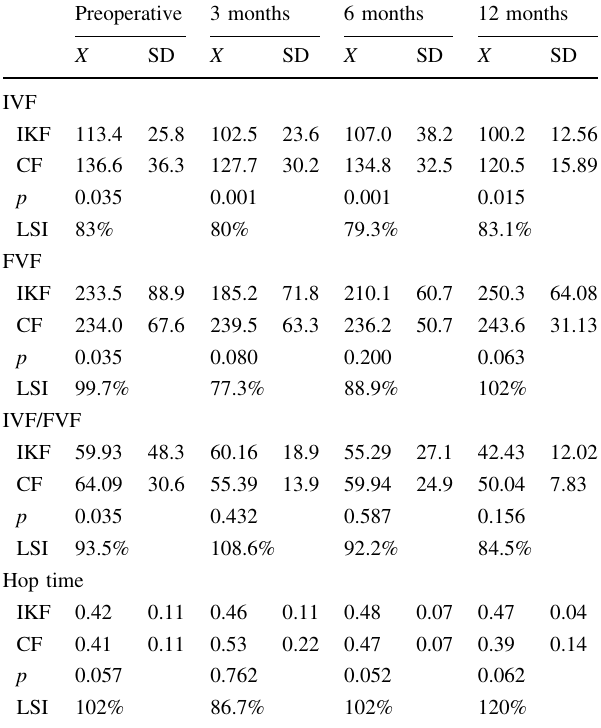
Table 6 Vertical hop test kinetics Preoperative